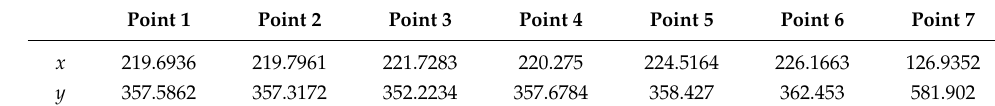
Figure 13. Intersection of simulations under Case I. Table 2. Coordinates of the intersections under simulation.